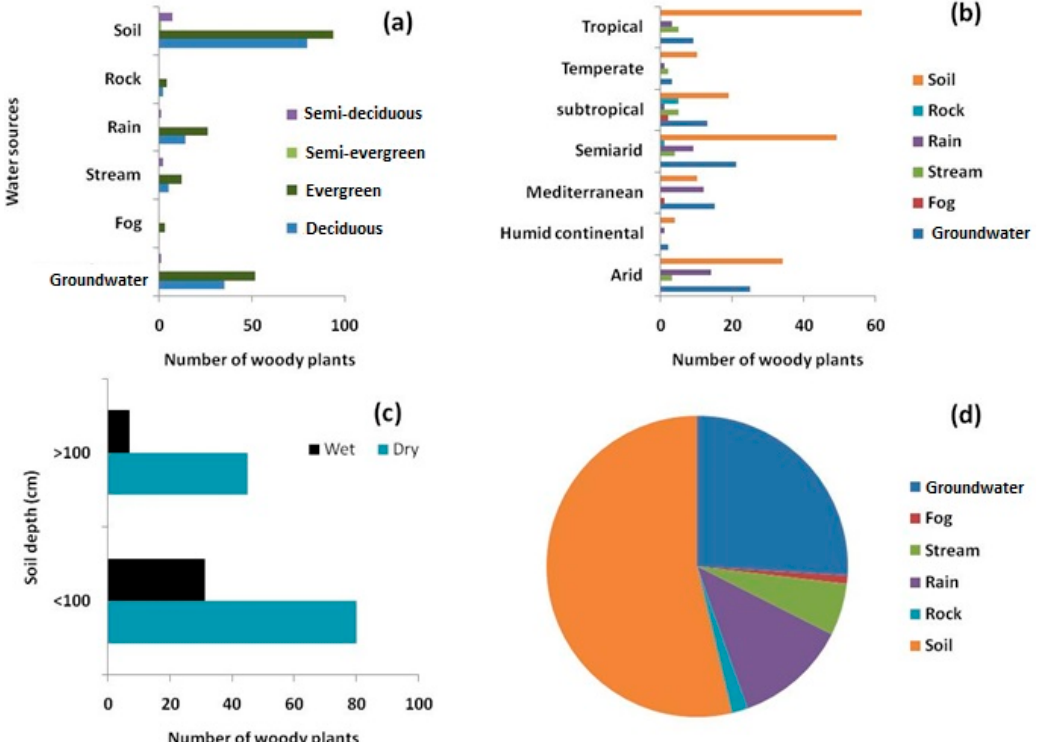
Figure 6. ( a ) Woody plant water source variation in relation to leaf phenology; ( b ) Climatic variation of plant water sources; ( c ) Seasonal variation in water uptake from different soil depths; ( d ) Proportion of water sources of woody species.